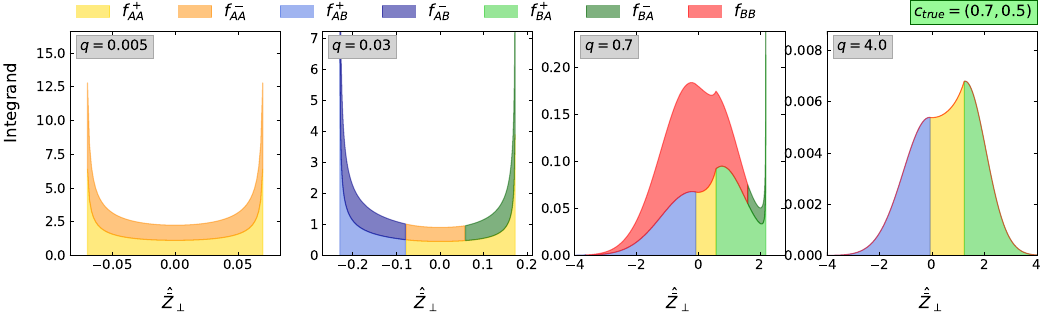
(cid:0) (cid:1) q for four different values of q ≡ q c true q